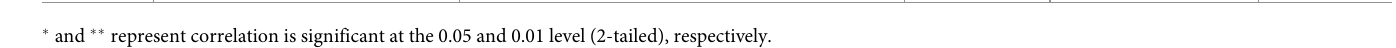
PLOS ONE | https://doi.org/10.1371/journal.pone.0242609 November23,